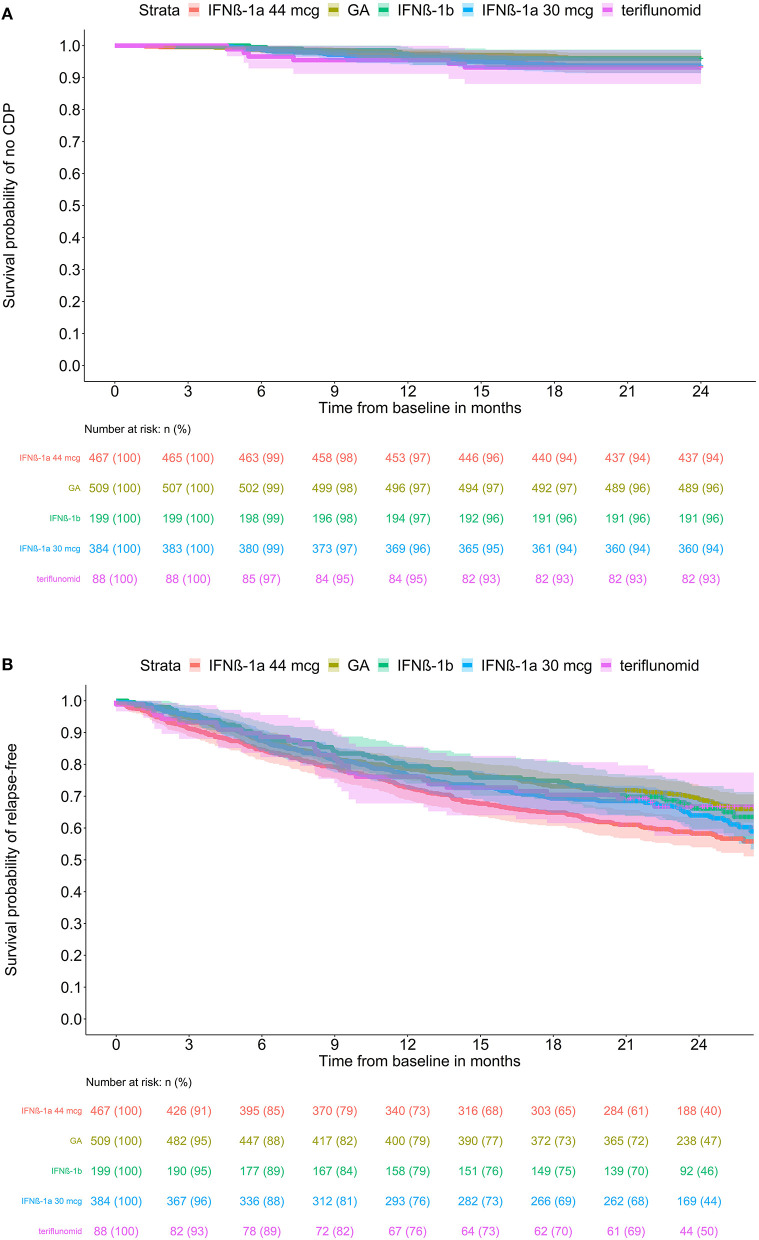
Estimated (K-M) survival functions (with 95% confidence intervals) for (A) CSP until month 24 and (B) relapse occurrence by treatment groups. Kaplan-Meier estimated survival functions with 95% confidence intervals by treatment group for ARR. The at-risk table contains the number (n) and percentage of patients at risk.